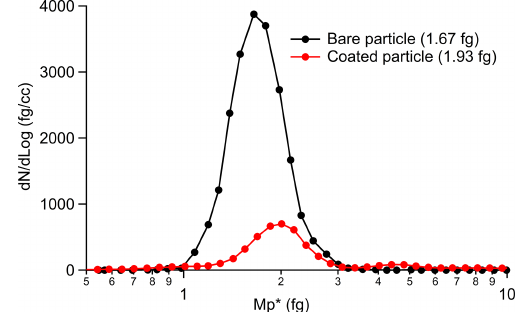
Figure A2. The raw data mass distribution of 200nm mCAST- black soot bare particles and H 2 SO 4 -coated particles. The black line shows the mass distribution of bare particles with a mass-mode value of 1.67fg derived from the log-normal distribution. The red line presents the mass distribution of H 2 SO 4 -coated particles with a mass-mode value of